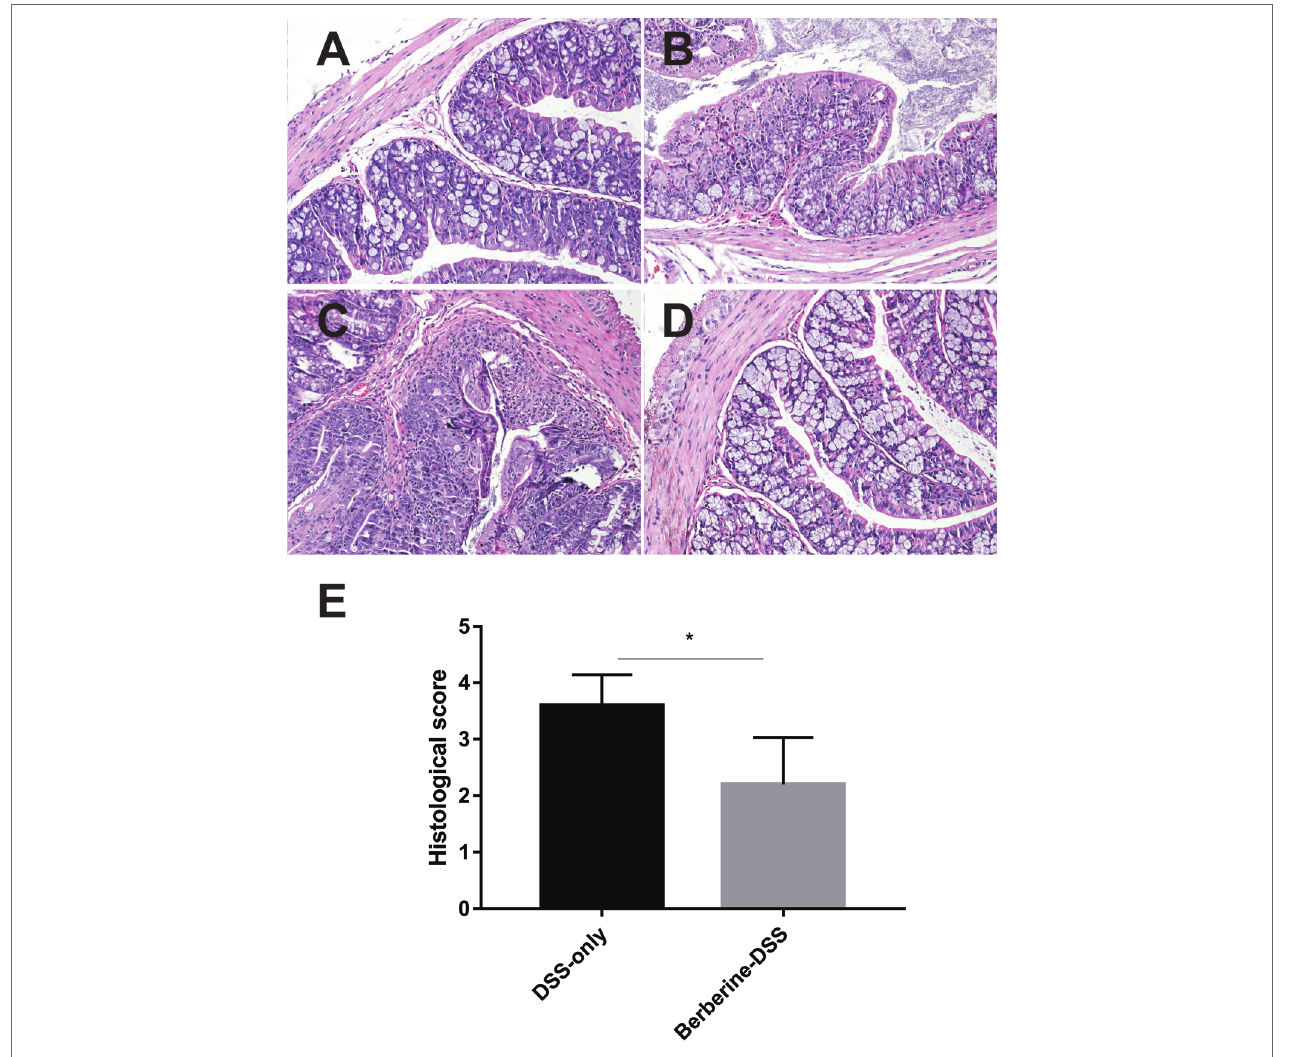
FIGURE 2 | Effects of berberine on the histopathological changes in colonic tissues. Normal control (A) , DSS-only (B) , and administration with berberine (i.g., 50 mg/kg)–water (C) and berberine (i.g., 50 mg/kg)–DSS (D) , (E) Scores of the histopathological changes in colonic tissues ( n = 7). * P <